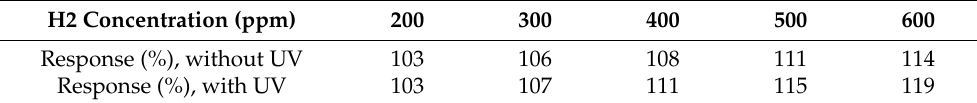
Table 2. H 2 sensing response of the CeO 2 -Pd-PDA/rGO heterojunction nanocomposite sensor towards H 2 with different concentrations without and with UV illumination at 100 ◦ C and 0%